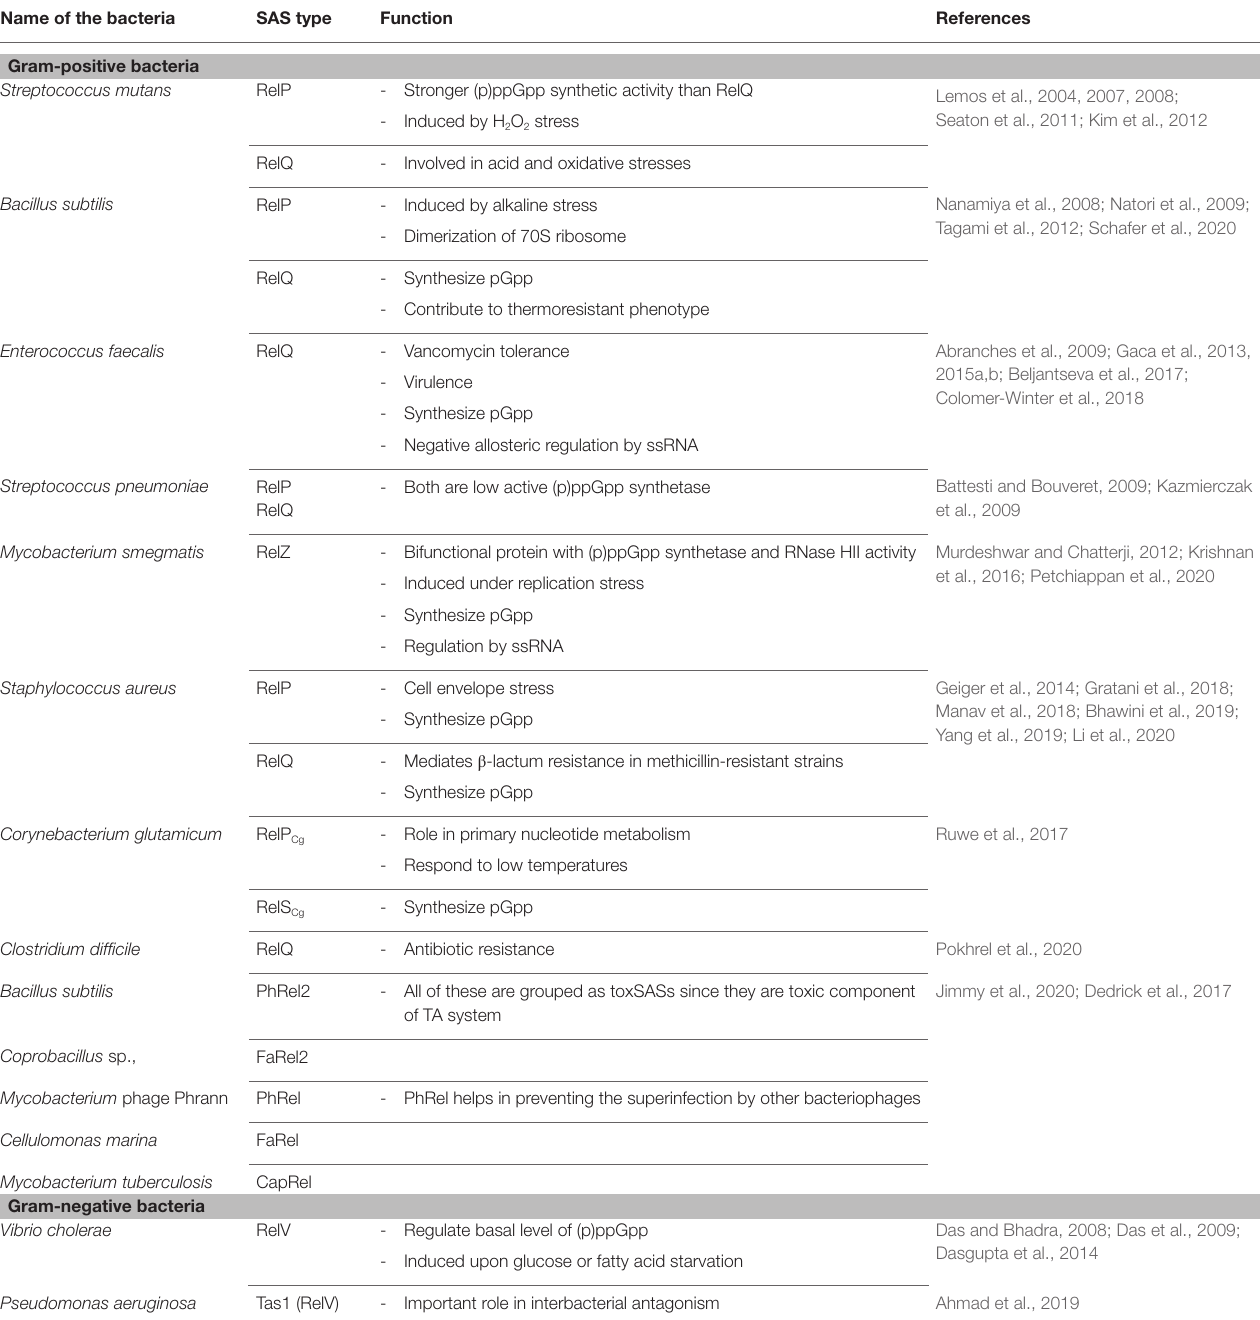
TABLE 1 | Short alarmone synthetases in